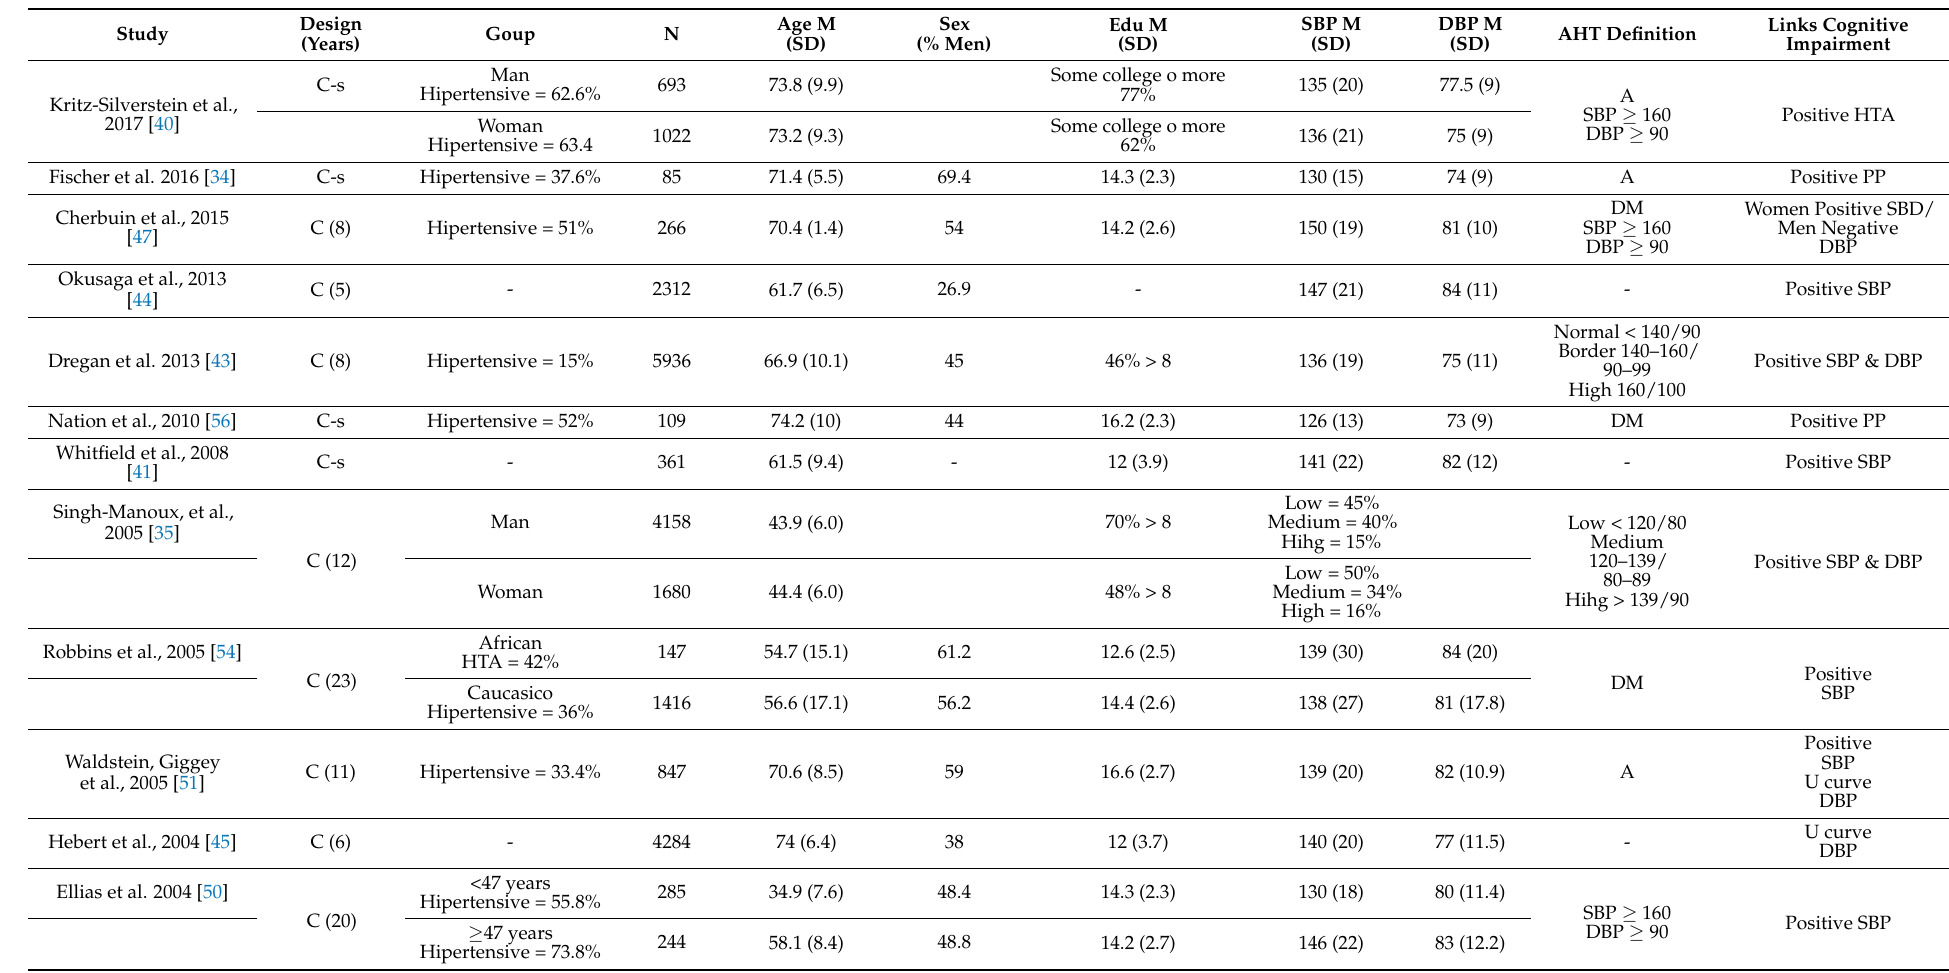
Table 1. Description of studies on blood pressure and cognitive functions in older